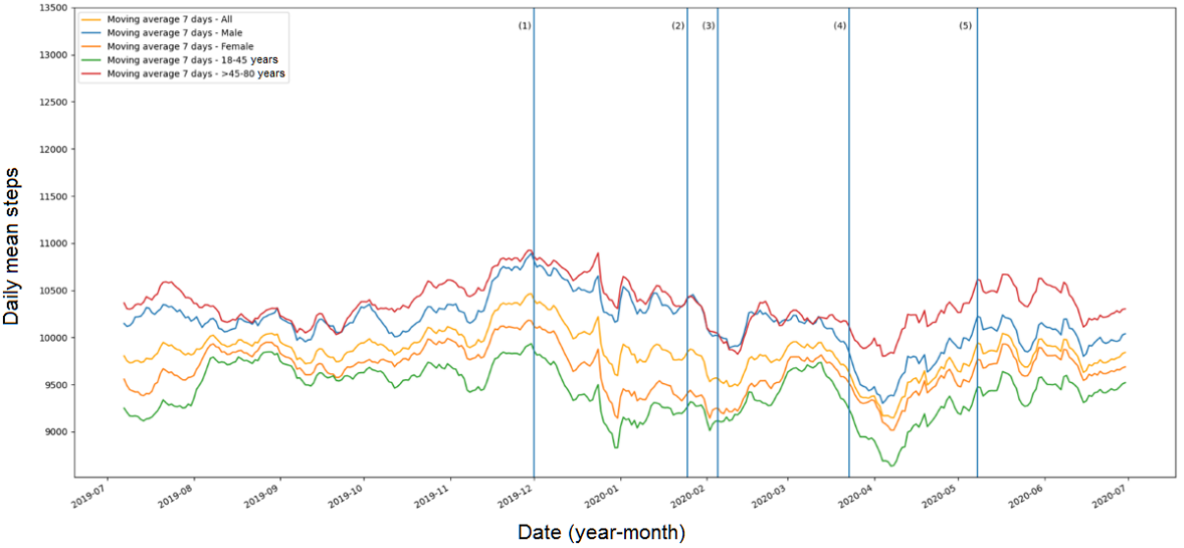
Figure 2. Daily mean steps for subgroups over time and key COVID-19 pandemic events. (1) First case with symptoms in Wuhan, China; (2) First case in Australia reported; (3) A 14-day ban for noncitizens arriving in Australia from China implemented; (4) Lockdown starts in Australia; (5) Australian Government starts relaxing